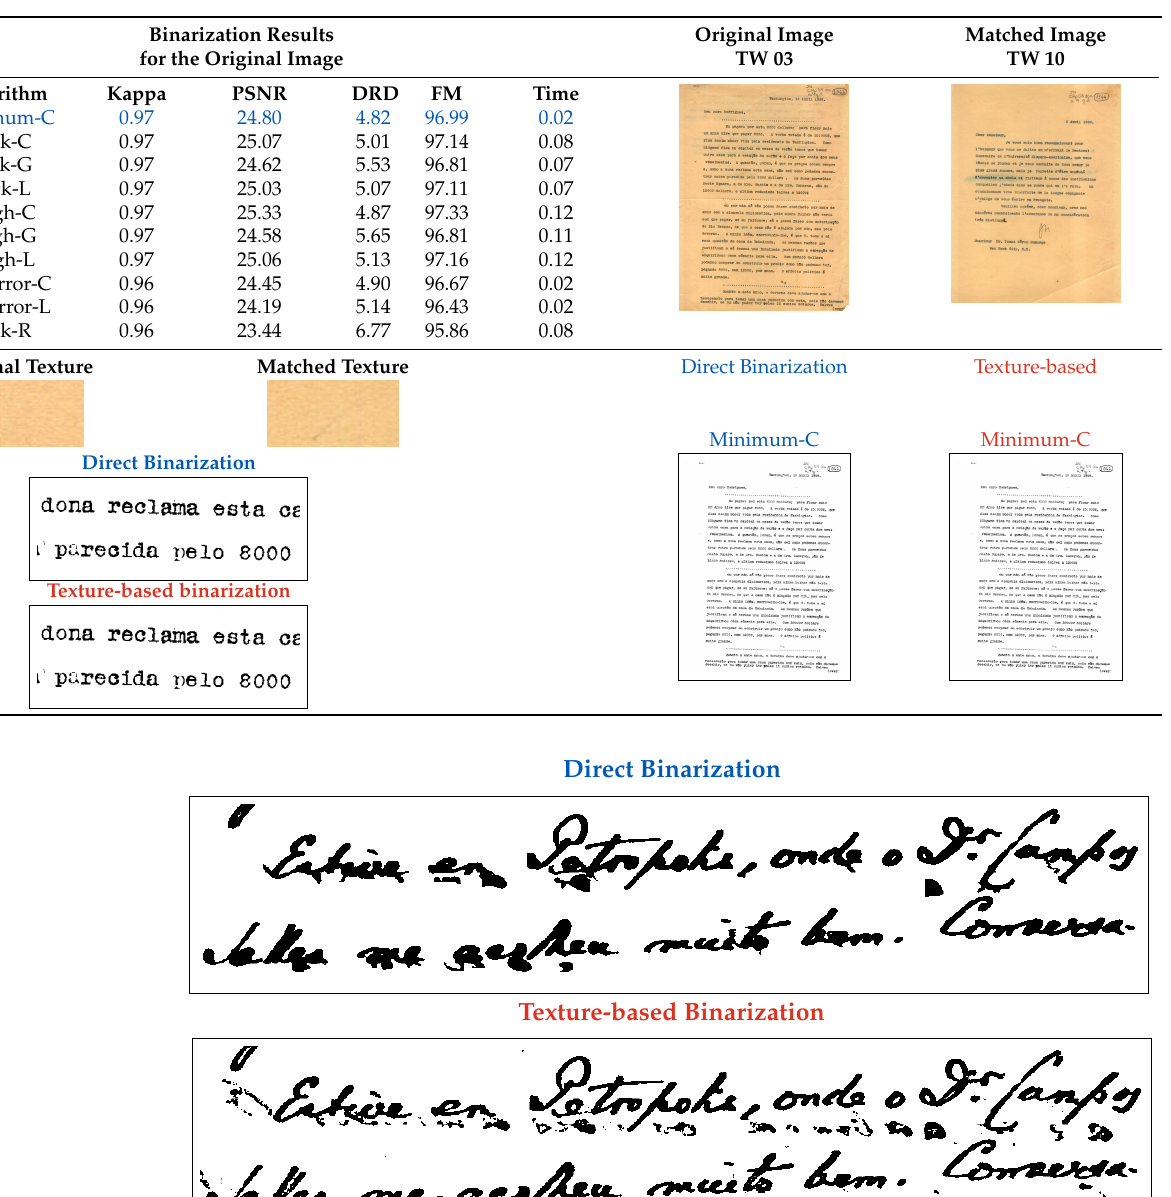
Table 12. Results for image matching with image TW 03.